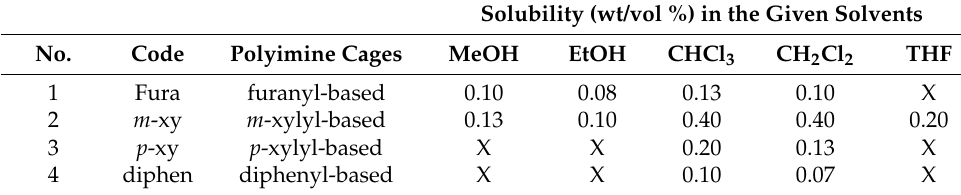
Table 1. Solubilities of the prepared cages. Solubility (wt/vol %) in the Given Solvents No. Code Polyimine Cages MeOH EtOH CHCl